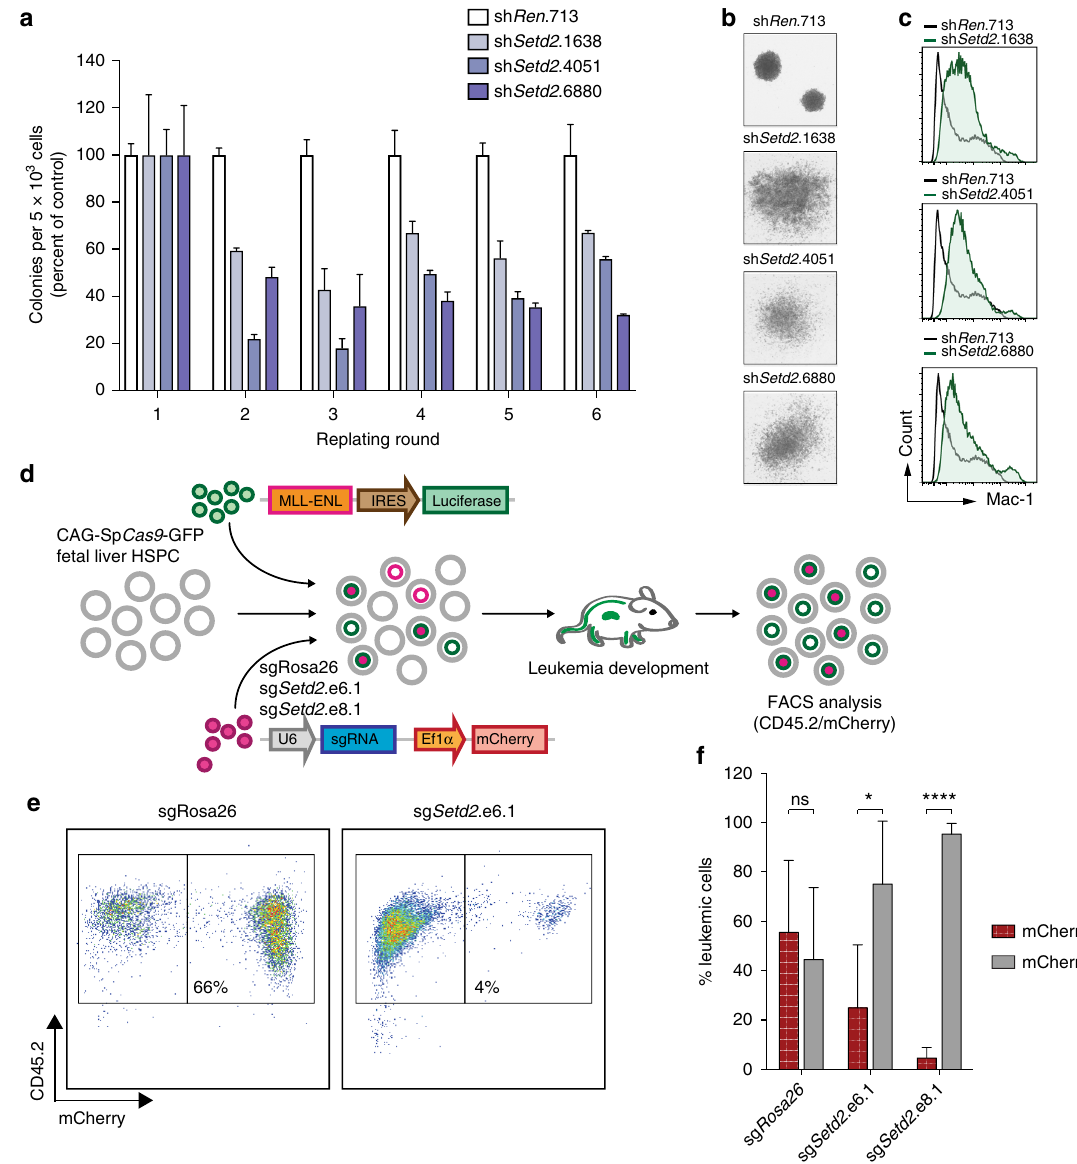
Fig. 7 SETD2 is required for oncogenic transformation by MLL-fusions. a Serial replating assay of primary MLL-AF9-transformed fetal liver cells upon shRNA-mediated knockdown of Setd2 . Colony numbers were normalized to cells expressing sh Ren .713 (mean ± s.d. n = 3). b Morphology of colonies of MLL-AF9-transformed fetal liver cells upon shRNA-mediated knockdown of Setd2 . c Flow cytometric analysis of Mac-1 expression of MLL-AF9- transformed fetal liver cells upon shRNA-mediated knockdown of Setd2 . d Schematic representation of the in vivo transformation assay. Fetal liver cells from SpCas9 -transgenic mice were co-transduced with retroviral vectors expressing MLL-ENL and Setd2 -targeting or control sgRNAs. Cells were transplanted into lethally irradiated C57BL/6 recipient mice. Terminally sick mice were sacri fi ced and bone marrow cells were analyzed. e Representative fl ow cytometry plots of donor-derived bone marrow cells from mice transplanted with MLL-ENL and a control sgRNA (sg Rosa .26, left) or a sgRNA targeting the SET domain of Setd2 (sg Setd2 e6.1, right). Live cells were gated. f Quanti fi cation of fl ow cytometry analysis of donor-derived bone marrow cells as shown in e (mean ± s.d. n ≥ 4). ns, not signi fi cant, * p < 0.05, **** p < 0.0001 ( t